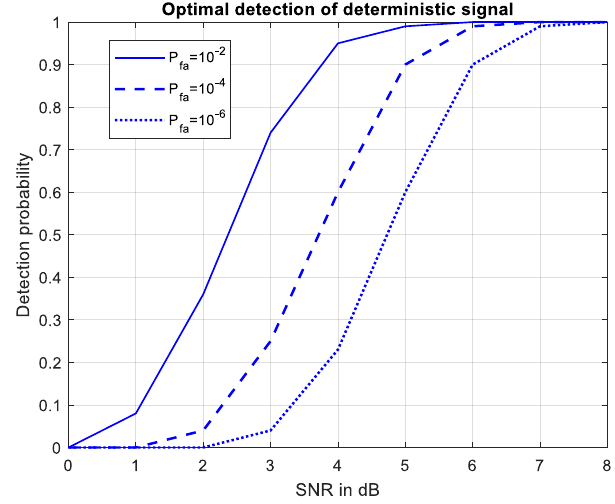
Figure 10. Probability of detection for various 𝑃 𝑓𝑎 .